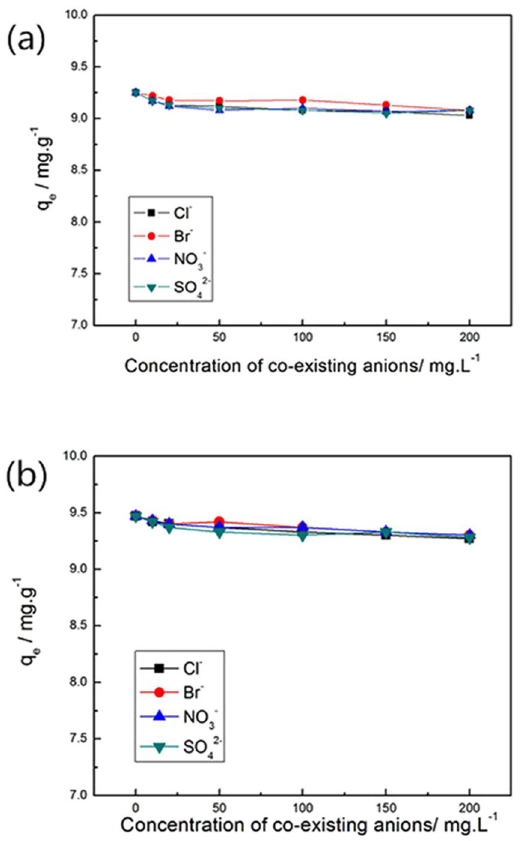
Figure 14. Effect of co-existing anions on the phosphate adsorption on ( a ) MIL-101(Fe) and ( b ) NH 2 -MIL- 101(Fe) ( Adsorbents, 12 mg; NaH